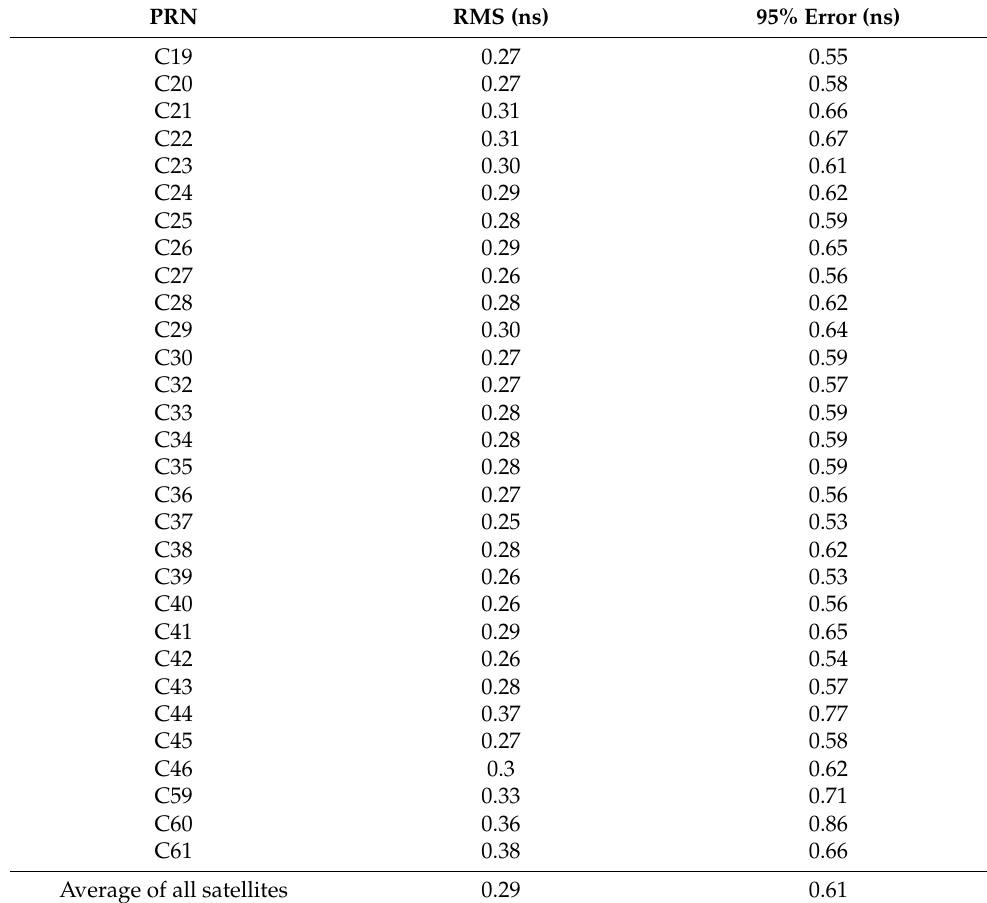
Table 2. Statistical results of 2-h prediction errors of two-way estimated clock offsets for 10 days.